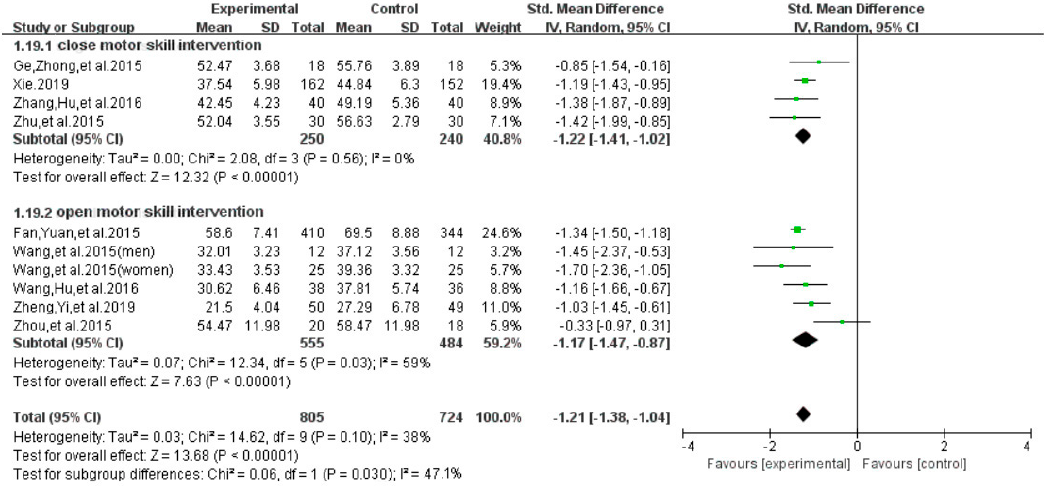
Figure 14. Effect of different exercise interventions on smartphone addiction.